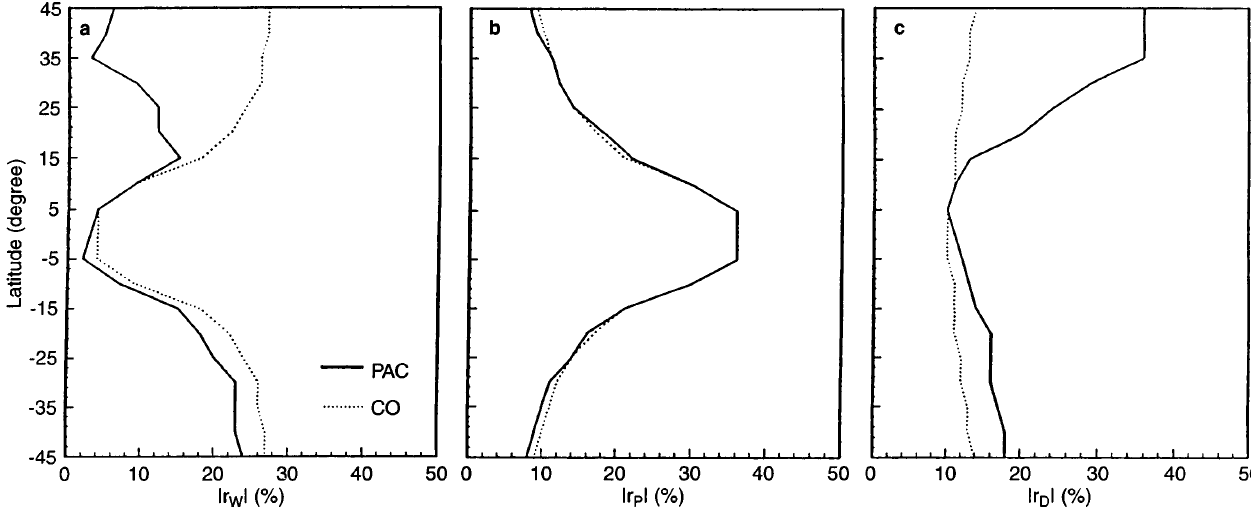
Fig. 5a–c. Linear energy flux coe(cid:129)cients (%) at di(cid:128)erent latitudes (degree) for di(cid:128)erent incident wave periods. a r